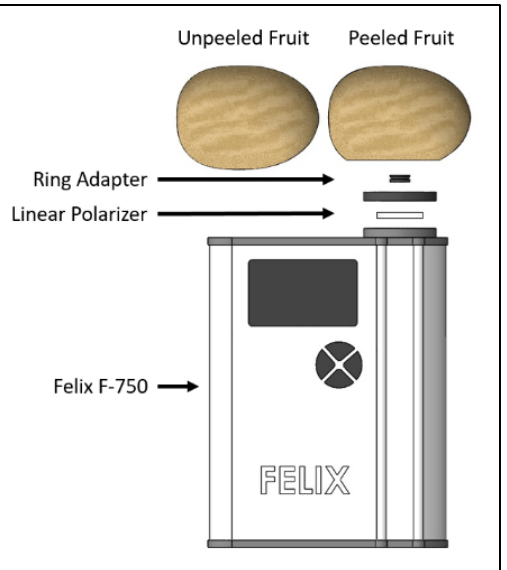
Figure 2. An illustration of the measurement of set up depicting peeled and unpeeled kiwifruit, a ring adapter, a linear polarizer and a Felix F ‐ 750.